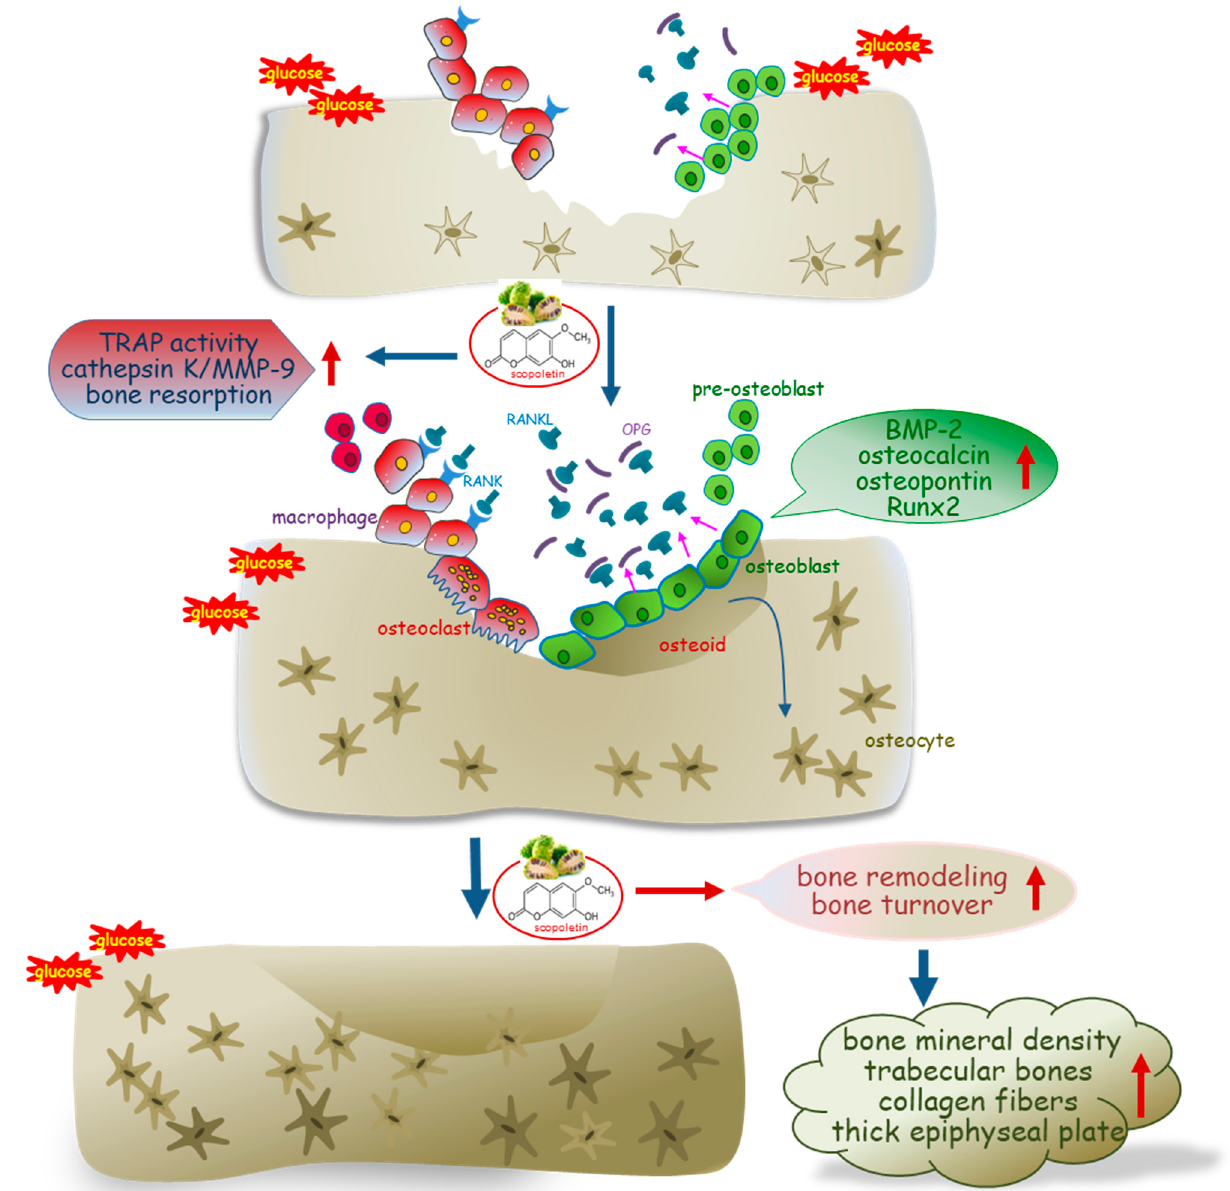
Figure 8. Schematic diagram showing the effects of scopoletin on bone turnover and remodeling in type 2 diabetic mouse model. The arrows indicate activation by scopoletin. TARP, tartrate-resistant acid phosphatase; RANK, receptor activator of nuclear factor- κ B; RANKL, RANK ligand; OPG, osteoprotegerin; BMP-2, bone morphogenetic protein-2; Runx2, Runt-related transcription factor 2.